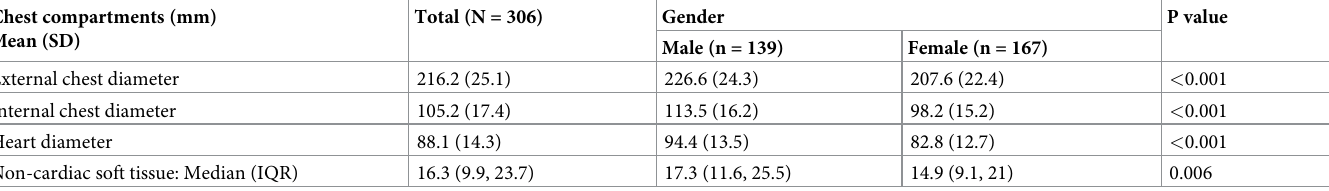
Table 2. Size of each chest